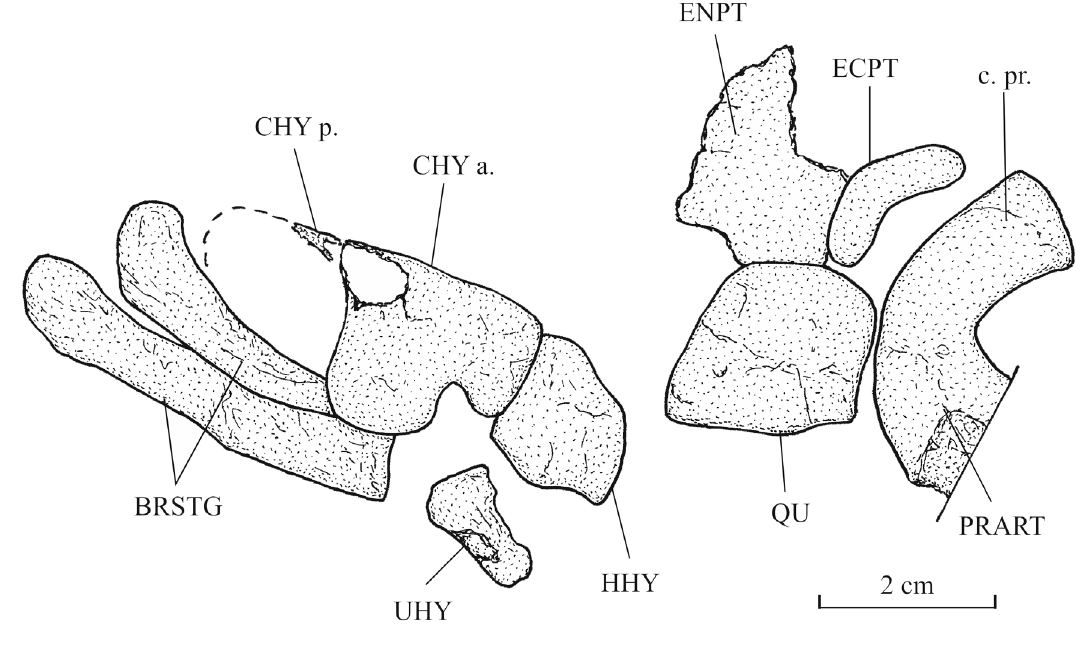
Fig. 19. Sigmapycnodus giganteus gen. et sp. nov., holotype, hyoid bar and coronoid region (CLC